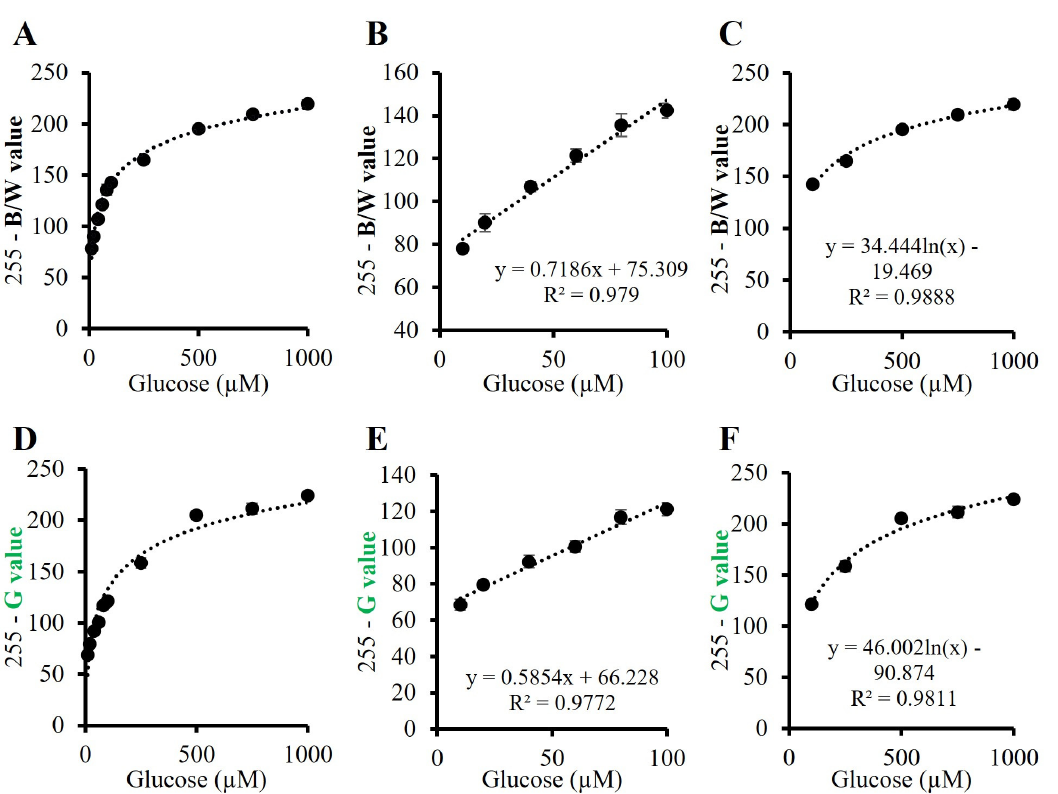
Figure 4. Calibration curves for glucose sensing in artificial sweat using the alginate biosystem. B/W values at 13 min of ( A ) glucose 10–1000 μ M, ( B ) glucose 10–100 μ M in a linear range and ( C ) glucose 100–1000 μ M in a logarithmic fit. Green (G) values at 13 min of ( D ) glucose 10–1000 μ M, ( E ) glucose 10–100 μ M in a linear range and ( F ) glucose 100–1000 μ M in a logarithmic fit (n = 4).